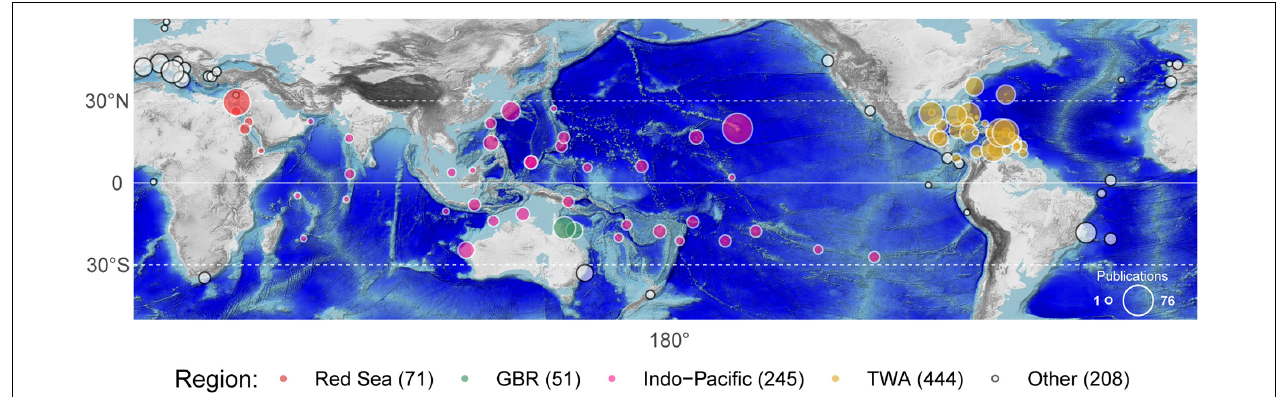
FIGURE 1 | Global distribution of mesophotic coral ecosystem studies across regions. Bubbles represent specific study locations, colored by region [red—Red Sea; green—Great Barrier Reef (GBR); pink—Indo-Pacific; and yellow—Tropical Western Atlantic (TWA)]. White bubbles indicate MCE sites not included in the analyses as they fell outside of our principal regions of interest (tropical coral reefs). The size of the bubble indicates the total number of publications from 1 to 76 as indicated by the scale on the bottom-right. Numbers in brackets, in the bottom region legend, indicate the total number of publications for the region. Publication data were collected from Mesophotic.org database for the period of 1960–2019 (Bongaerts et al., 2019). Base-map was derived from the GEBCO global bathymetry model (GEBCO Compilation Group, 2020).